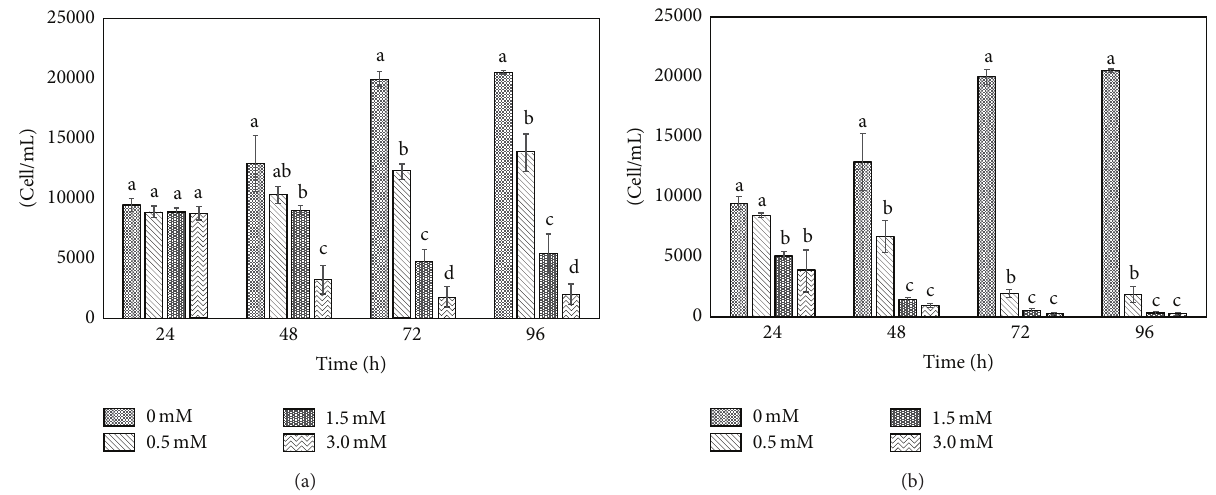
Figure 1: Cell growth of lung cancer cells exposed to 0; 0.5; 1.5; and 3.0 mM Se supplied as (a) SeMet or (b) SSe for 96h. Values are the arithmetic mean ± standard deviation ( 𝑛 = 3 ). Different letters show significant differences in cell growth between each concentration at the same time ( 𝑃 < 0.05 ).